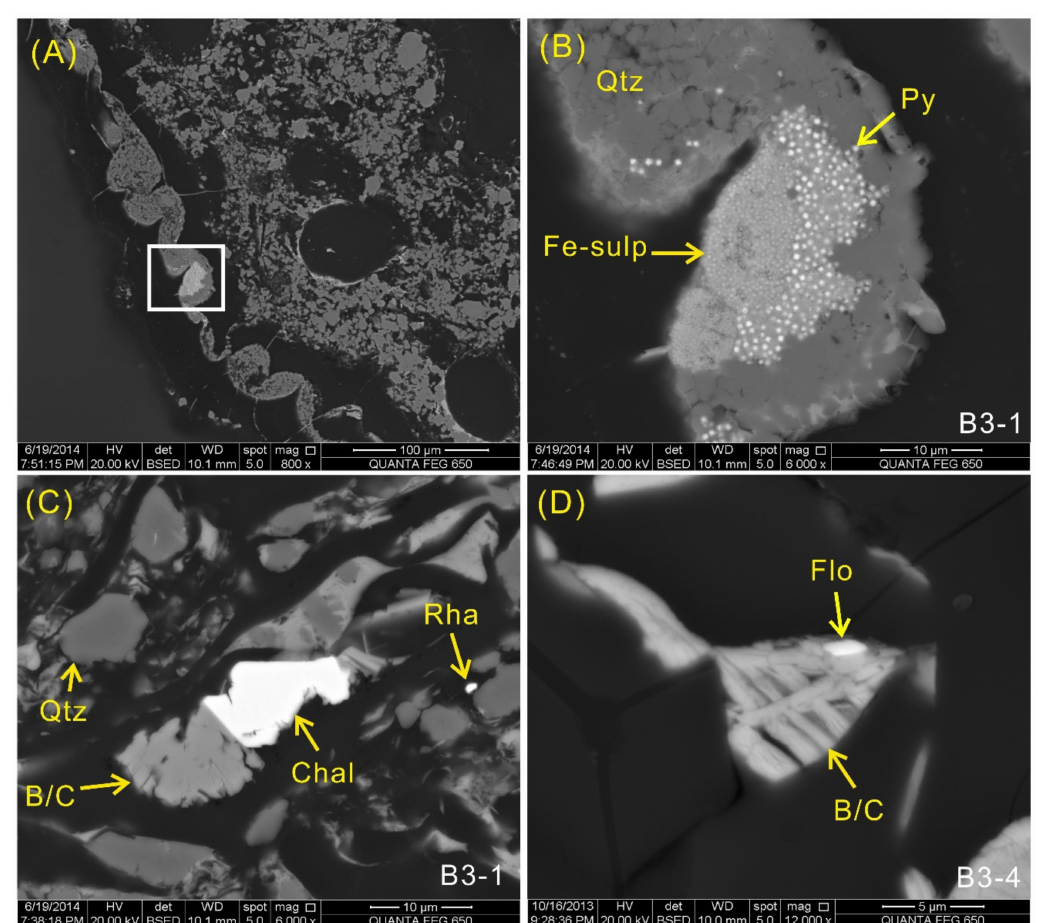
Figure 10. SEM back-scattered electron images of minerals in coal samples. ( A ) Cell-filling pyrite, iron-sulphate mineral, and quartz in sample B3-1. ( B ) Enlargement of rectangle in ( A ). ( C ) Rhabdophane and cell-filling chalcopyrite, quartz, and interstratified berthierine/chamosite in sample B3-1. ( D ) Cell-filling florencite and interstratified berthierine/chamosite in sample B3-4. B/C: interstratified berthierine/chamosite. Qtz: quartz. Py: pyrite. Fe-sulp: Fe-sulfate mineral. Rha: rhabdophane. Chal: chalcopyrite. Flo: florencite. B/C: interstratified